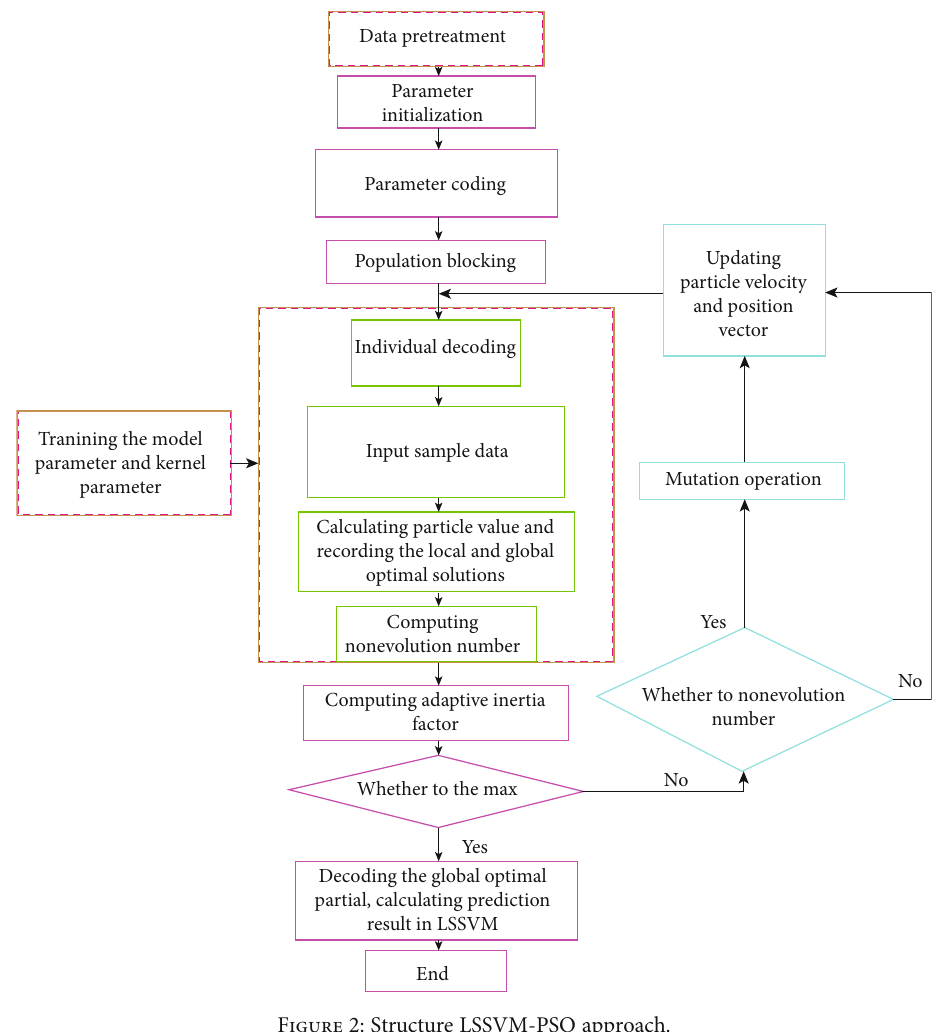
Figure 2: Structure LSSVM-PSO approach.